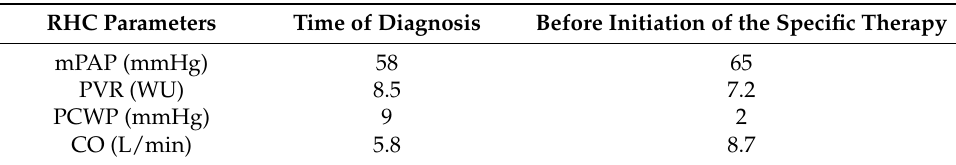
Table 3. Right heart catheterization hemodynamic parameters (Patient